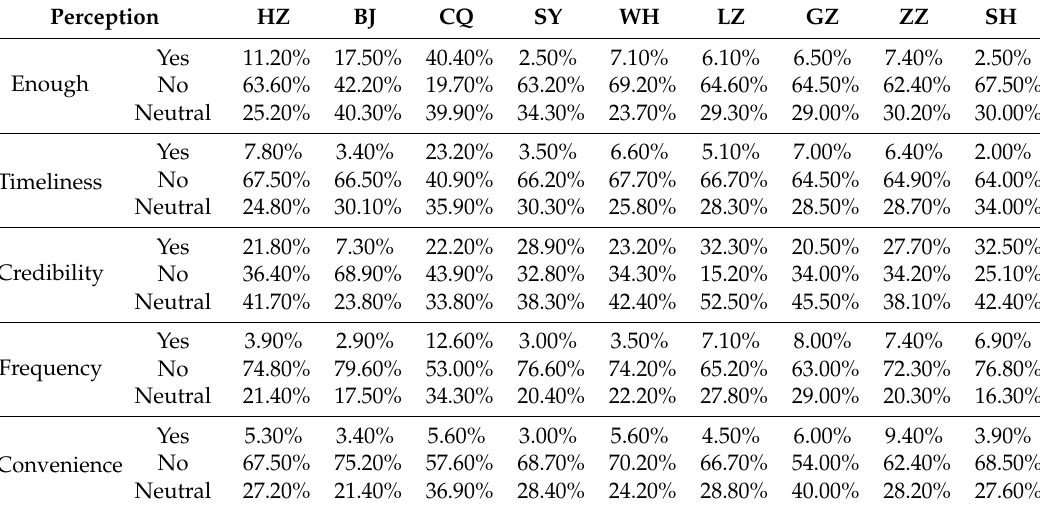
Table 4. Residents’ perception on execution capability of local agencies.